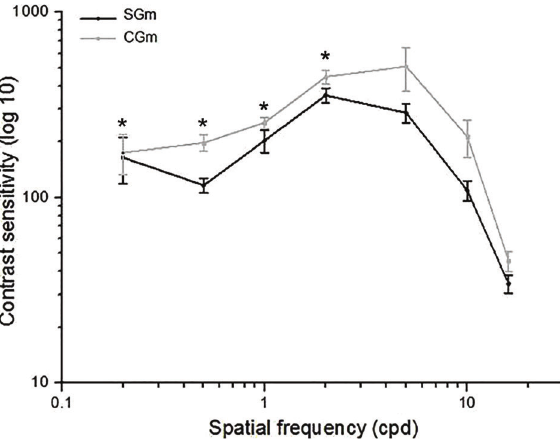
Figure 1. Male study group (SGm) and male control group (CGm) contrast sensitivity curve. The data are reported as means and the vertical lines indicate the standard error of the mean for each spatial frequency (0.2, 0.5, 1.0, 2.0, 5.0, 10.0 and 16.0 cpd). *P o 0.05; **P o 0.01 (Mann-Whitney test).